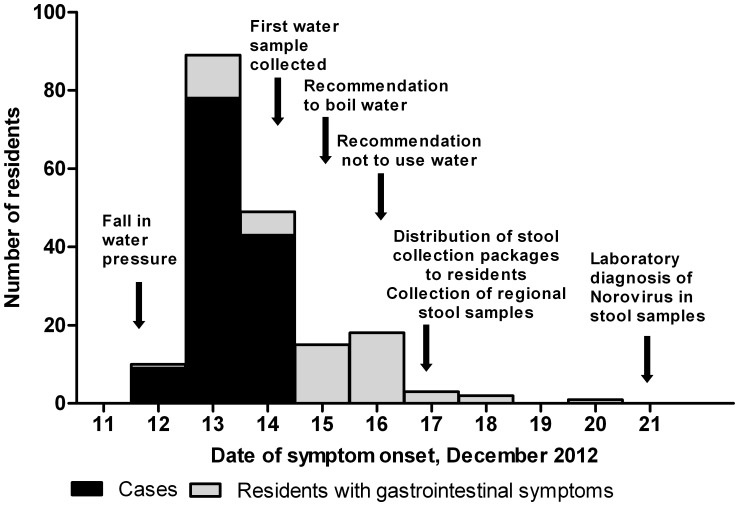
Date of onset and case status of individuals with gastrointestinal symptoms.Number of individuals in the cohort with gastrointestinal symptoms by date of symptom onset and case status (N = 187), 12–21 December 2012, Kalundborg, Denmark. Individuals not fulfilling the inclusion criteria were excluded from the cohort. Individuals with gastrointestinal symptoms, but not fulfilling the case definition are indicated as residents with gastrointestinal symptoms. Arrows indicate important events in the outbreak investigation.